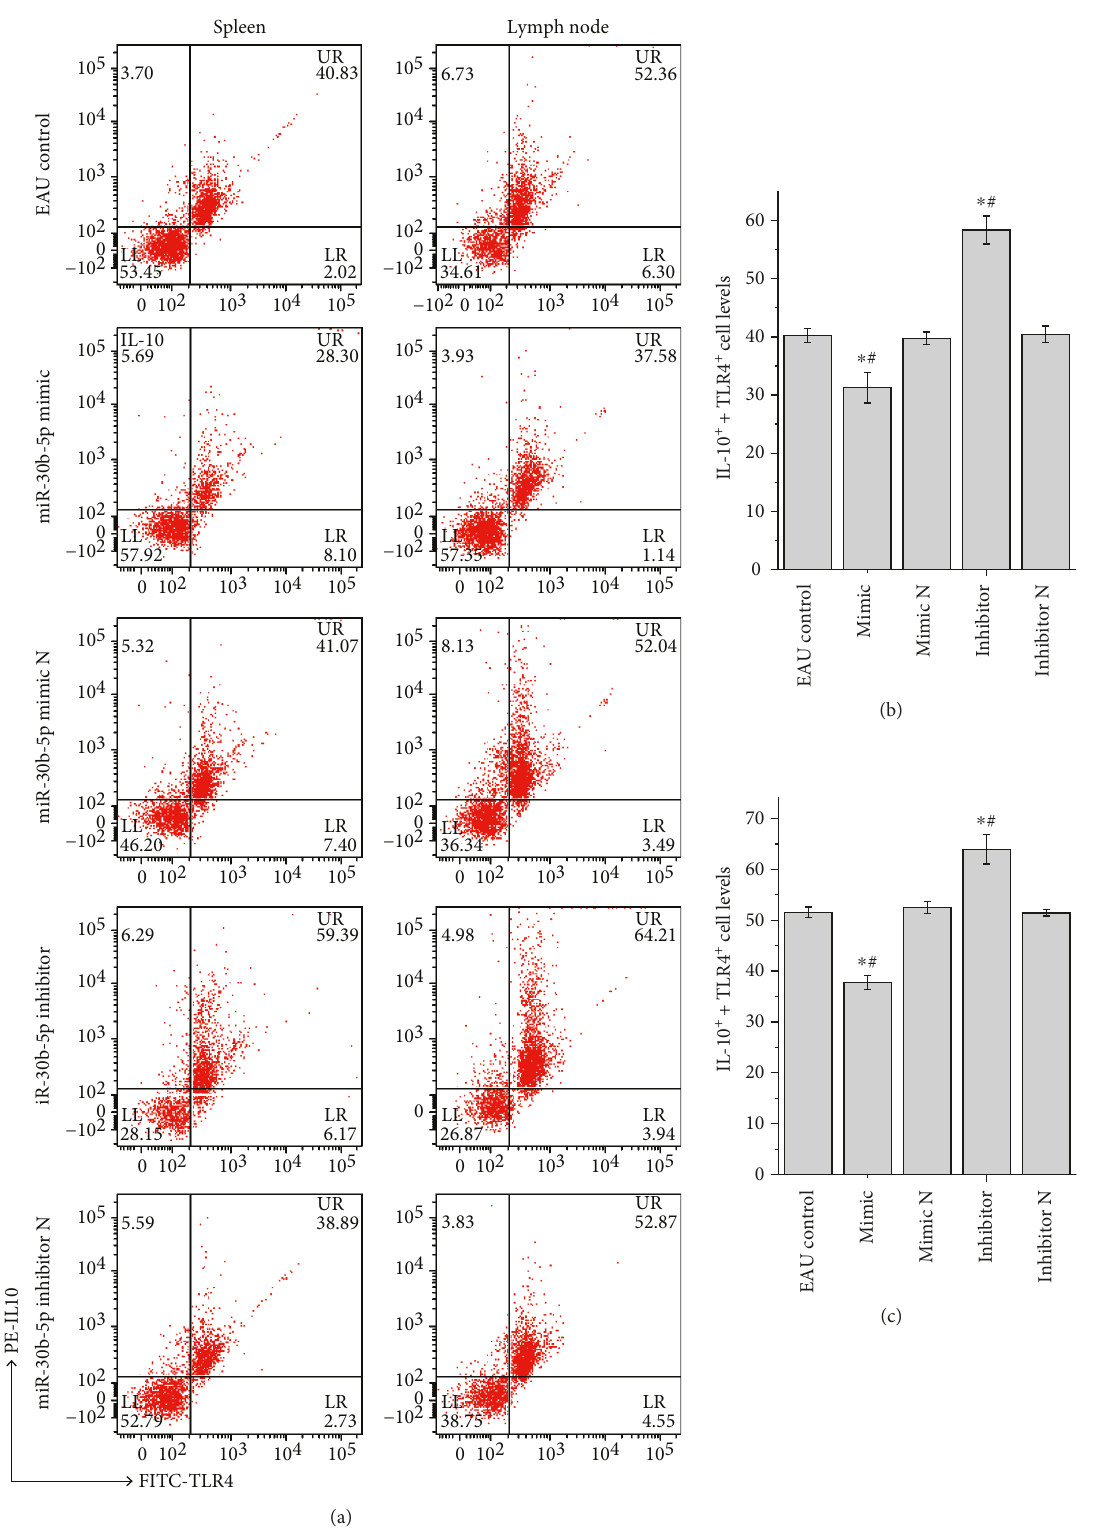
Figure 6: Changes in the levels of both IL-10 and TLR4 positive cells detected by fl ow cytometry in EAU control, rno-miR-30b-5p mimic, mimic negative, inhibitor, and inhibitor negative groups after transfection for 72 h. Note: (a) expressions of both IL-10 and TLR4 positive cells; (b) histogram analysis of IL-10 and TLR4 positive cell levels in EAU spleen after di ff erent treatments; (c) histogram analysis of IL-10 and TLR4 positive cell levels in EAU lymph node after di ff erent treatments. ∗ P < 0 05 compared with the EAU control group and # P < 0 05 compared with the relative negative control